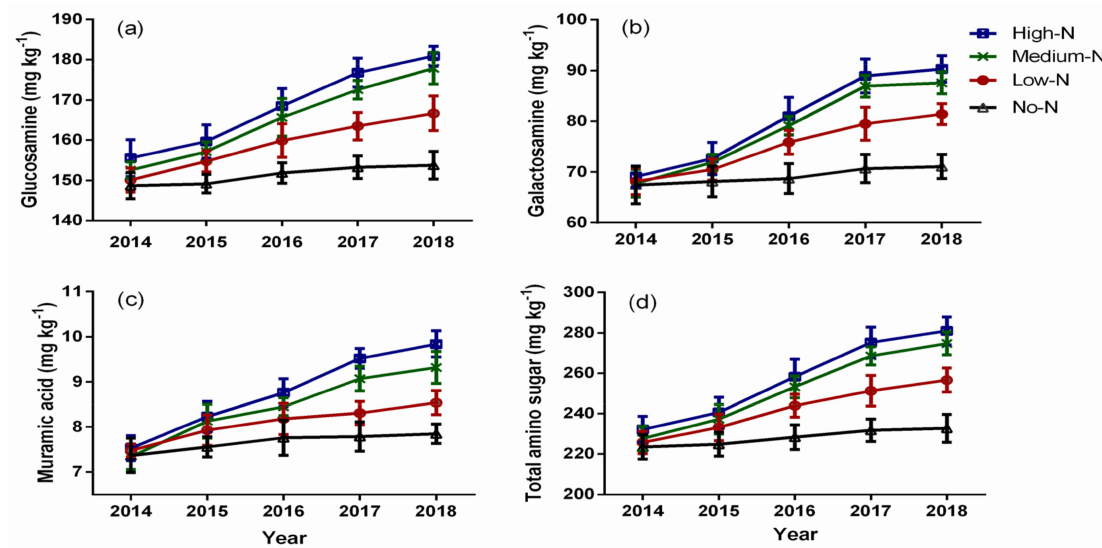
Figure 1. Effects of chronic nitrogen enrichment on glucosamine ( a ), galactosamine ( b ), muramic acid ( c ), and total amino sugar ( d ). Bars represent ± standard error of means with four replications. Table 2. Effects of nitrogen enrichment on the glucosamine and galactosamine ratio (GluN/GalN), the glucosamine and muramic acid ratio (GluN/MurN), and soil organic carbon and pH content from 2014 to 2018. Parameter